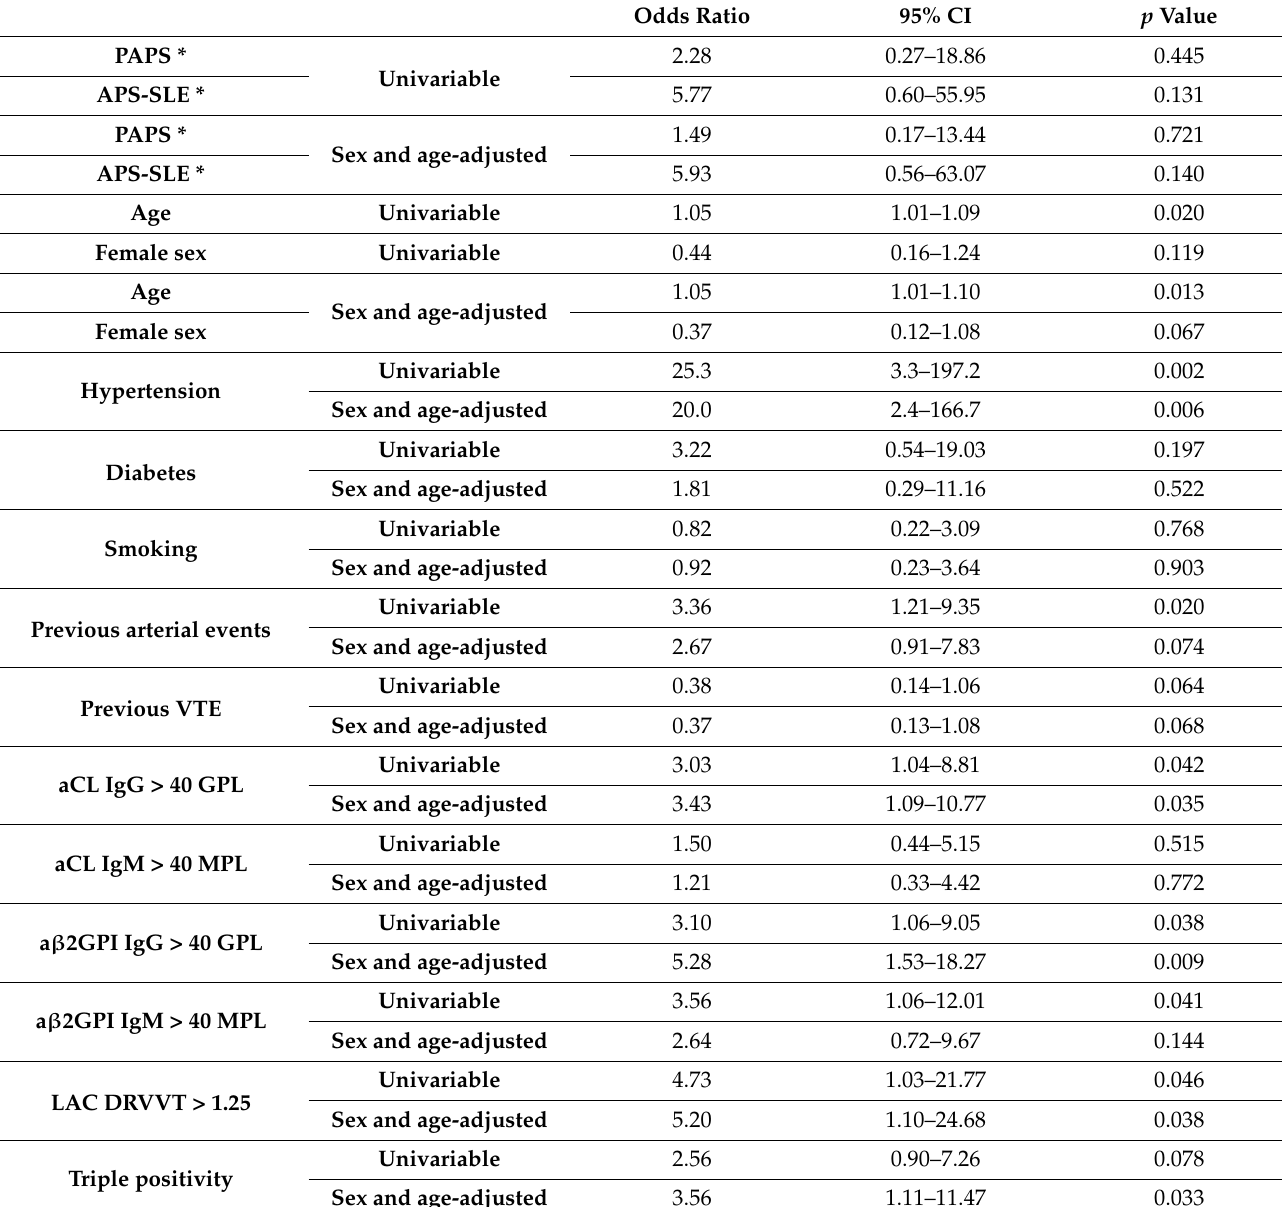
Table 3. Logistic regression analysis of factors associated with heart failure with preserved ejection fraction. Odds Ratio 95%